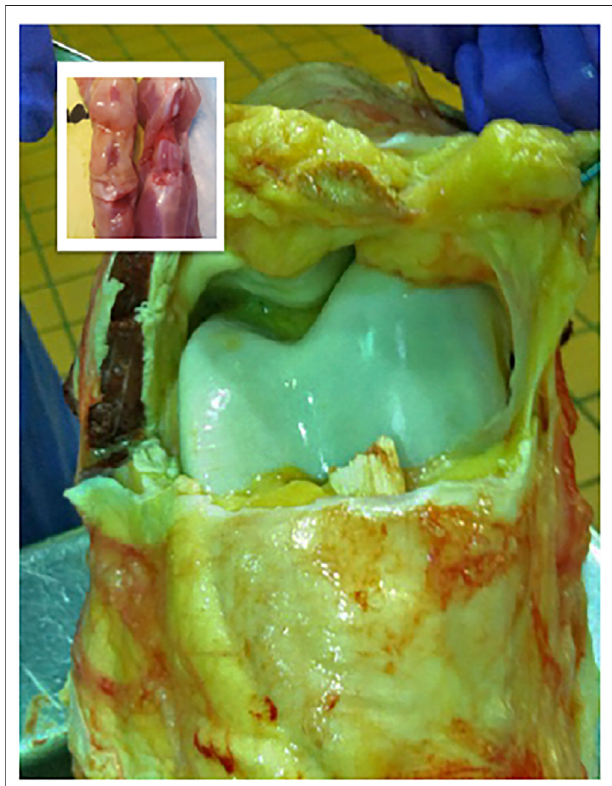
FIGURE 4 | Comparison of the internal anatomic structures of the sti fl e joints(hind knees) oftheadult rat (inset) and thehorse, which iscomparable in size to the human knee. The striking differences in magnitude, volume and thickness of the tissues underscore the practical challenges associated with the scale-up of a gene-based therapy to a large mammalian